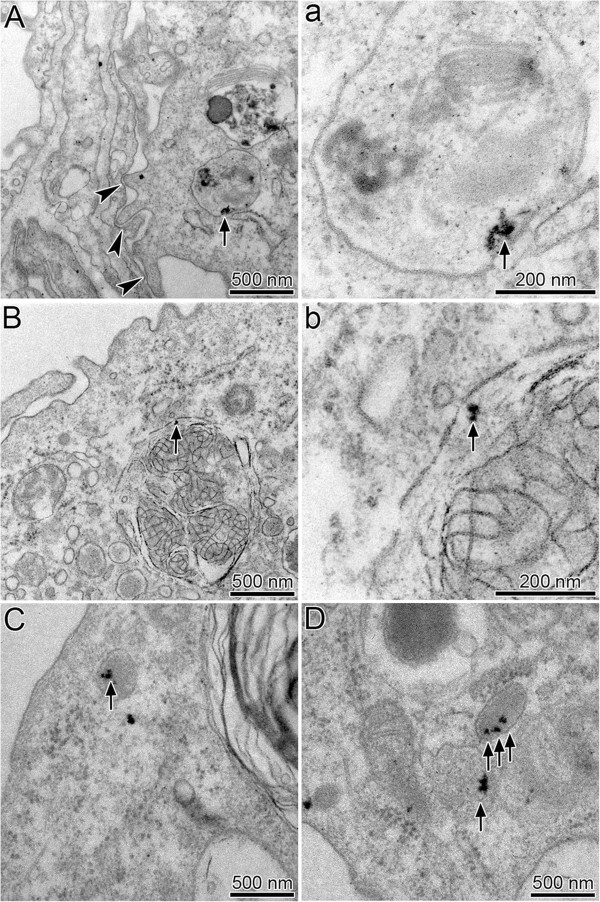
Ultrastructural localization of TiO2NP in lung tissue. TiO2NP (arrows): A) in a vesicle of a macrophage that is closely associated with the alveolar epithelium (arrow heads); a) high magnification micrograph of the NP-containing vesicle. B) in large vesicle of macrophage containing lamellar structures (surfactant); b) high magnification micrograph of the NP-containing phagolysosome. C) and D), in vesicles of alveolar type 2 epithelial cells. Note the close association of the TiO2NP to the vesicle membrane.